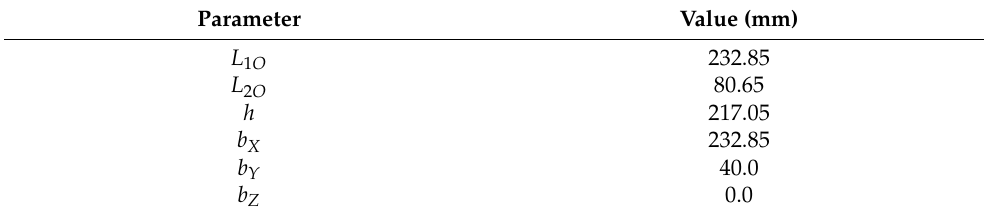
Table 1. Mechanical